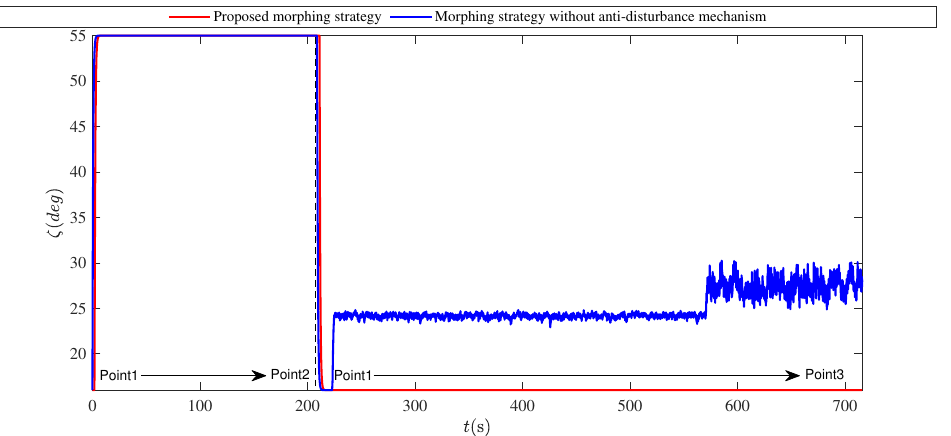
Figure 23. ζ of the comparative simulation in Section 5.3.